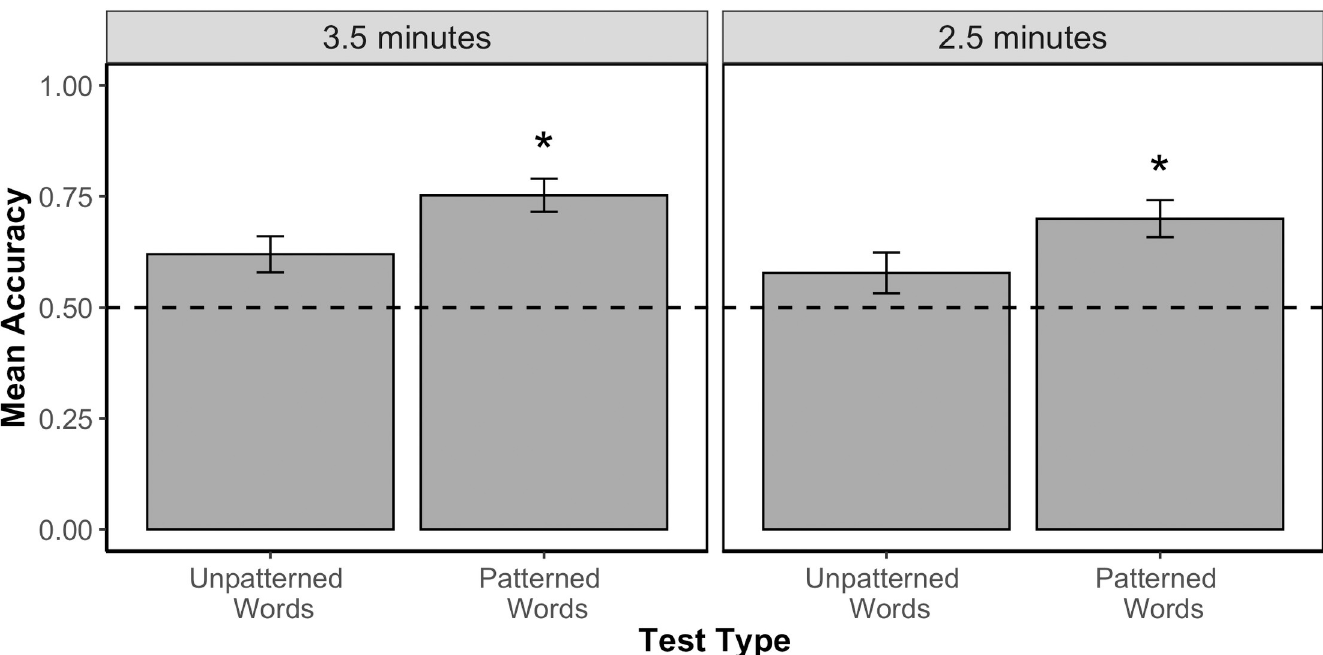
Fig 2. Accuracy by exposure length in Experiment 2. Mean proportion correct (and standard error of the mean) for Word vs. Partword test items presented in Experiment 2 after 3.5 minutes or 2.5 minutes of exposure to the language. Dotted line indicates chance performance (0.5). Asterisk denotes significant difference from chance